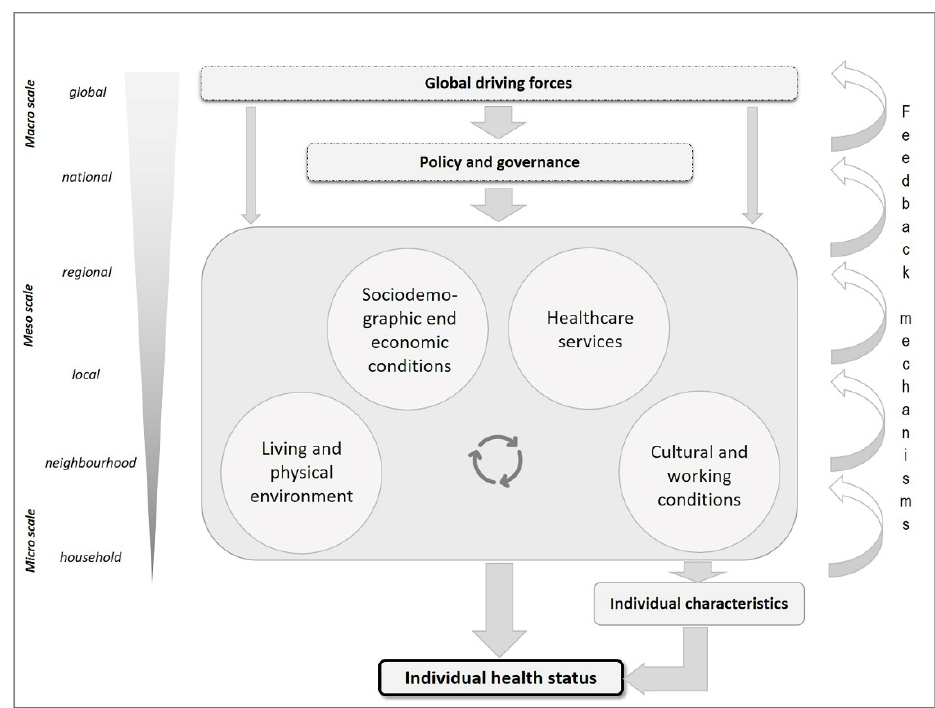
Figure 3. Spatial aspects of health—developing a conceptual